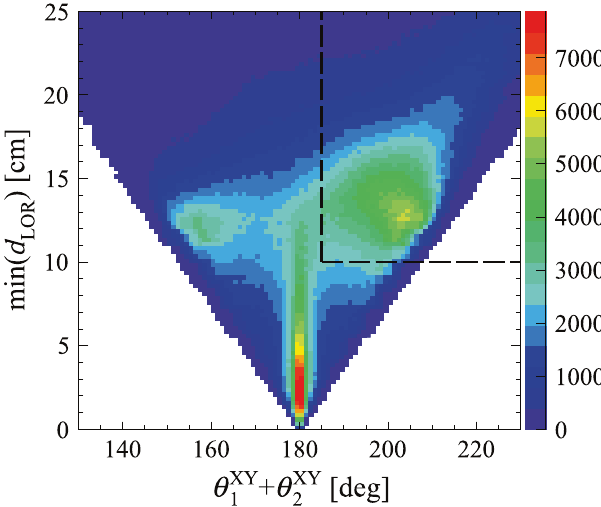
Fig. 6 Separation of ortho-positronium annihilations from direct two- photon events. Distribution of distance between the β + source location and the closest hypothetical 2 γ annihilation point on a line of response between two recorded photon interactions vs. the sum of the two smallest angles between azimuthal coordinates of the recorded γ interaction points. Events located in the signal-speci fi c upper right region of the distribution (marked with dashed black line) are retained for the analysis in order to discriminate background events from 2 γ annihilations (see Fig. 3b –